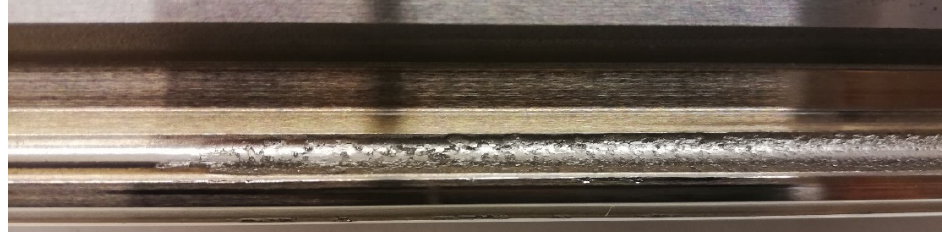
Figure 7. The pitting of the guiding profile.